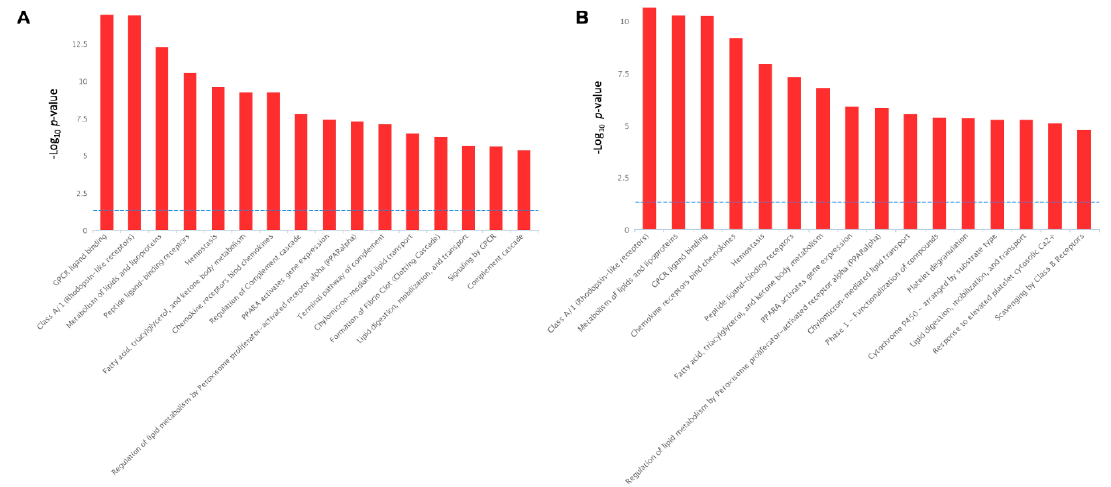
Figure 9. Biological pathways significantly enrichment by the serotonin-induced ( A ) and TNF- α - induced ( B ) differentially expressed genes in porcine mature adipocytes (pMA) of intramuscular origin. The -Log 10 p -value of 1.3 was considered as the significant threshold as indicated by the blue dotted line.